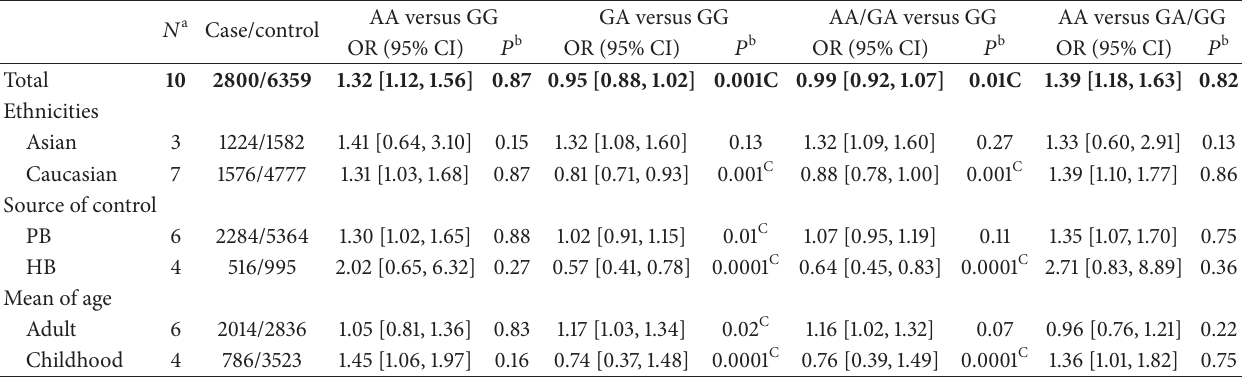
Table 4: Stratified analyses of the IL-1RA polymorphism on asthma risk in meta-analysis.